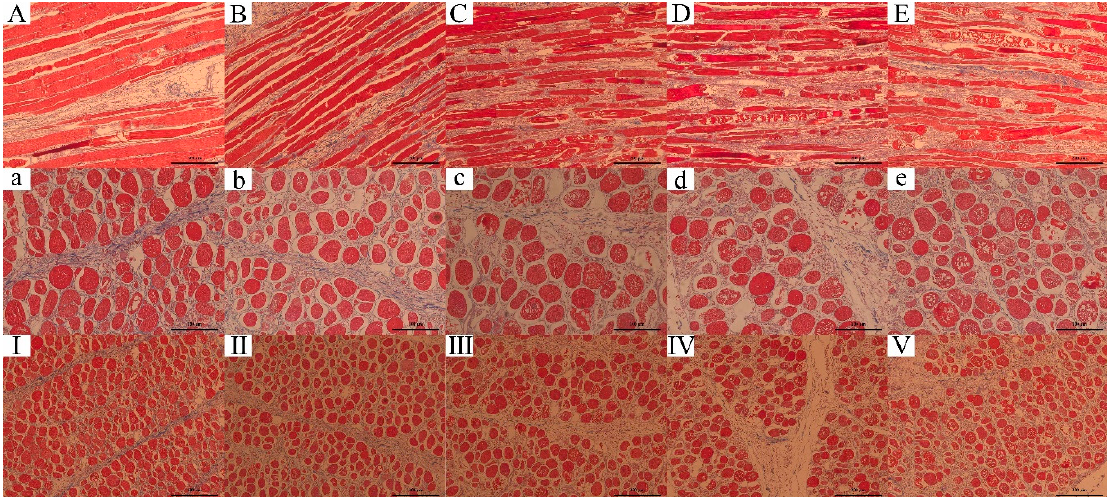
Figure 6. Effect of different ultrasound power on histology of WB. Masson staining of tissue. From left to right are the Control, 300 W, 600 W, 900 W and 1200 W groups. ( A – E ): longitudinal section of myofibril, scale bar = 200 μ m; ( a – e ): transverse section of myofibril, scale bar = 100 μ m; ( Ι – Ѵ ): transverse section of myofibril, scale bar = 200 μ m.